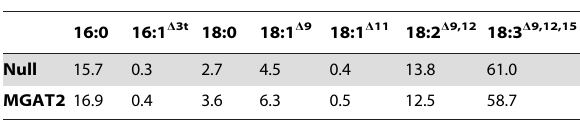
Table 1. Major fatty acids of total lipids isolated from representative null and transgenic MGAT2 N. benthamiana